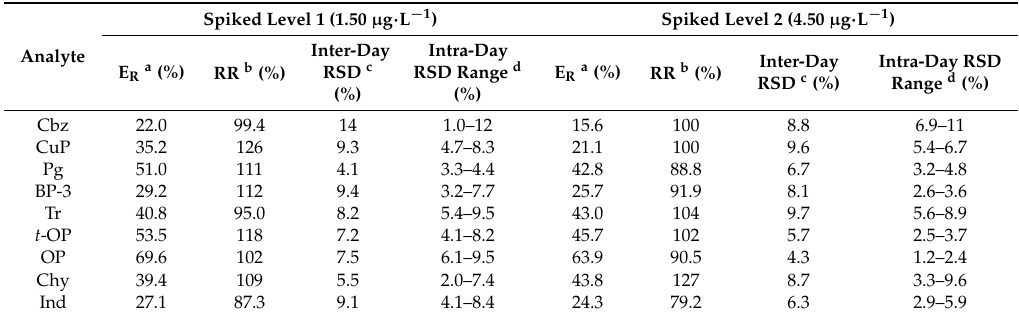
Table 3. Analytical performance of the entire D- µ SPE-HPLC-DAD method in terms of relative recovery, extraction efficiency, and inter-day precision with aqueous standards.